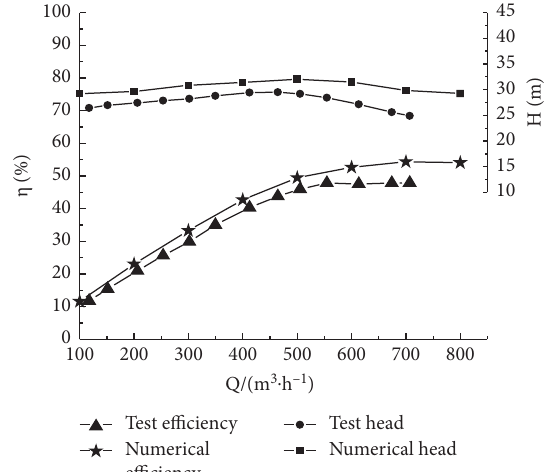
Figure 7: Comparison between the test results of the optimized model and prototype